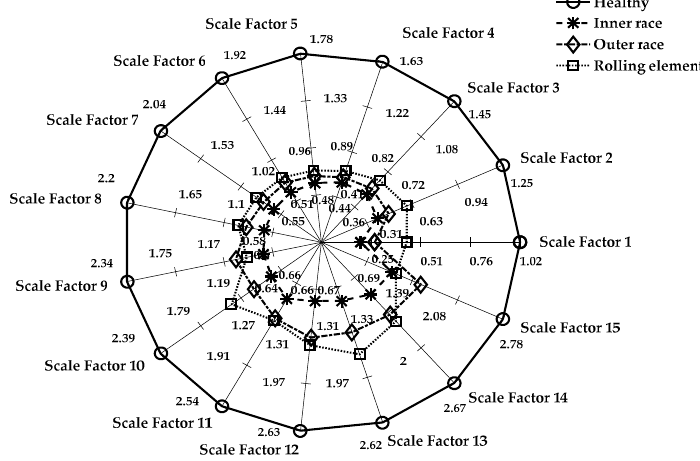
Figure 10. Spider plot for MSE of the PF4 (Case 2): damage size is 0.021 inches.